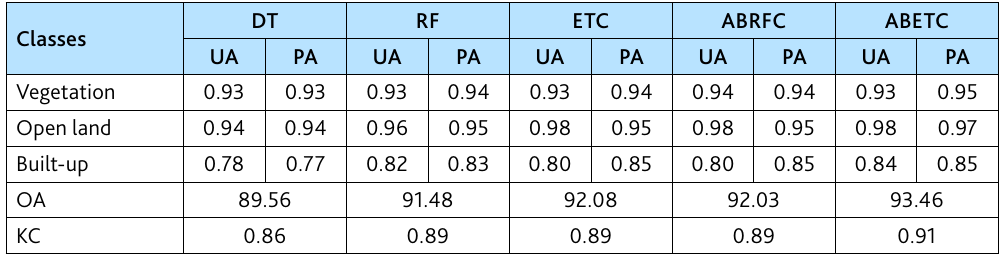
Table 2. Accuracy Statistics comparison for DT, RF, ETC, ABRFC, and ABETC Classifiers for Ahmedabad